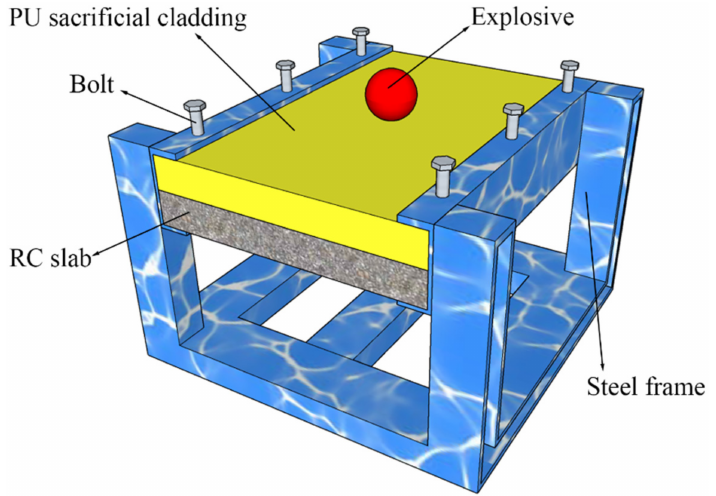
Figure 6. Schematic diagram of the test device.